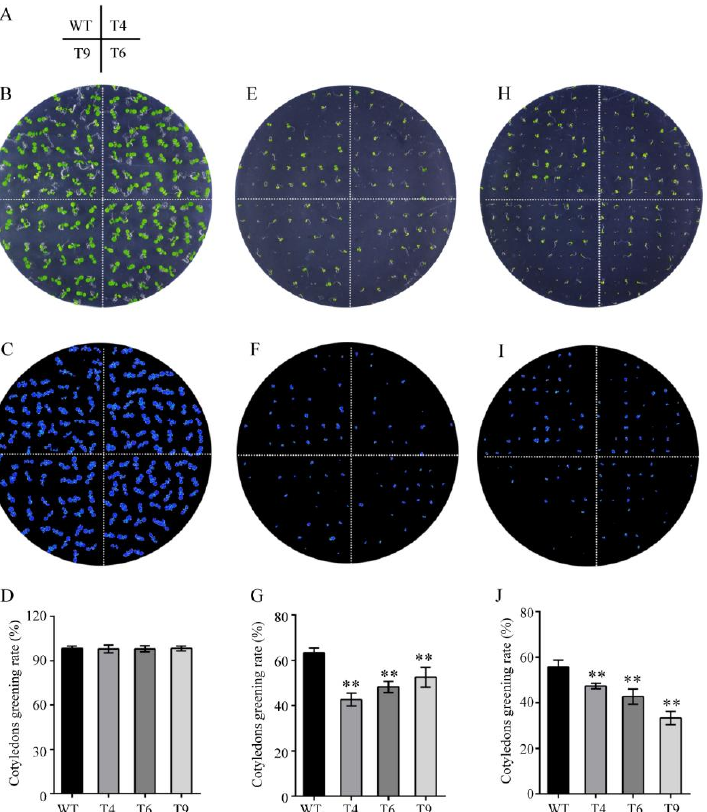
Figure 5. Cotyledon greening rate of FtMYB22 transgenic Arabidopsis (T4, T6, and T9) lines and WT lines. ( A ) The distribution of each line on the plate. ( B – D ) Cotyledon greening under the normal condition. ( E – G ) Cotyledon greening under mannitol condition. ( H – J ) Cotyledon greening under salt condition. ( B , E , H ) are characterized in daylight. ( C , F , I ) are characterized under chlorophyll fluorescence. WT, wild-type. Data are presented as mean ± SD values of three independent experiments. Error bars represent SD. ** means extremely significant difference at p < 0.01 level. Similarly, there were no differences in root lengths between the transgenic lines and WTs under the normal condition (Figure 6A,B). Transgenic seedlings had shorter root lengths than WTs under the water deficit and salt conditions. The root growth of all lines was inhibited under mannitol stress. The root length under the water deficit condition was only 43.3% of that of the normal condition in the WTs. The root lengths of the three transgenic lines were only 76.1%, 83.8%, and 71.3% of those in the control group for T4, T6, and T9, respectively, which were significantly lower than those of WTs (Figure 6C,D). In addition, similar growth trends were also obtained under NaCl treatment. Under salt stress, the root growth of all lines was only 30.2% of that of the normal growth condition. These data showed that the root lengths of three transgenic lines were only 80.1%, 78.2%, and 68.8% of those in the control group under the same conditions (Figure 6E,F) for T4, T6, and T9, respectively. This further indicated that FtMYB22 played a negative regulatory role in stress response.